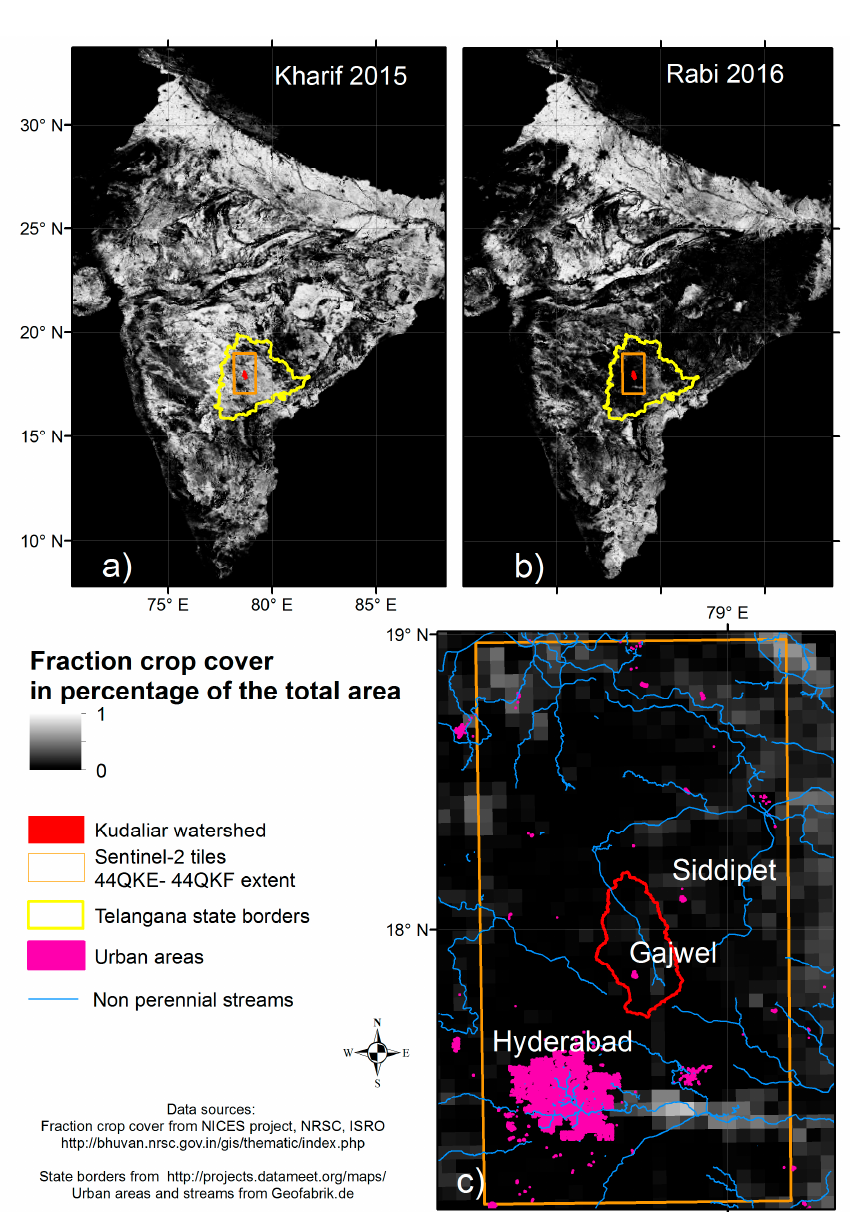
Figure 1. Location of the study area in Telangana State, South India. The Kudaliar watershed area is embedded in two Sentinel-2 tiles (orange outline). ( a ) Fraction crop cover in wet Kharif season 2015 (July to November); ( b ) fraction crop cover in dry Rabi season 2016 (December 2015 to March 2016); ( c ) fraction crop cover for the study area in Rabi 2016. This product is provided at 5 km resolution from optical remote sensing at 56 m resolution